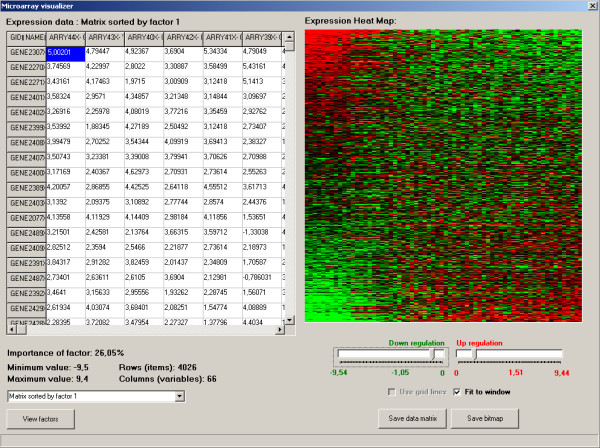
Graphical User Interface for biclustering application. Each factor is used to sort the original data matrix to emphasize the clustering structure of the data. Biclusters can be browsed in textual and graphical format. Thresholds to select the biclusters of interest can be interactively selected